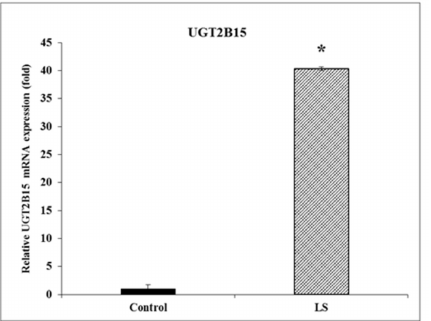
Figure 1. Gene expression of UGT2B15 mRNA in LS patients. Total RNA was obtained from four LS- and four healthy control-derived EBV-immortalized lymphoblastoid cell lines. UGT2B15 mRNA levels were measured by RT-QPCR, as described in Section 2. Results are expressed as UGT2B15 mRNA levels normalized to β -actin mRNA values. A value of 1 was assigned to the UGT2B15 mRNA levels in control cells. Bars denote mean ± SEM. * p < 0.01 vs. control